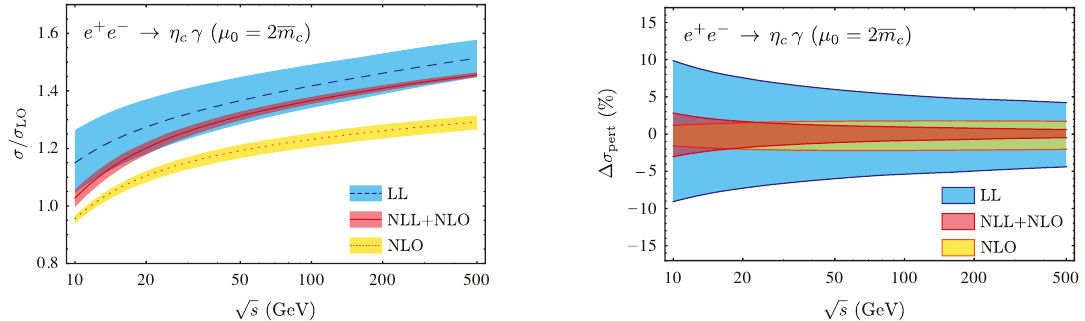
Figure 1 . Left panel: LL, NLL+NLO and NLO cross sections normalized by the LO cross section. p The scale choices are (cid:22) 0 = 2 m c and (cid:22) = s . Bands are perturbative uncertainties only. right panel: perturbative uncertainties in percentage.